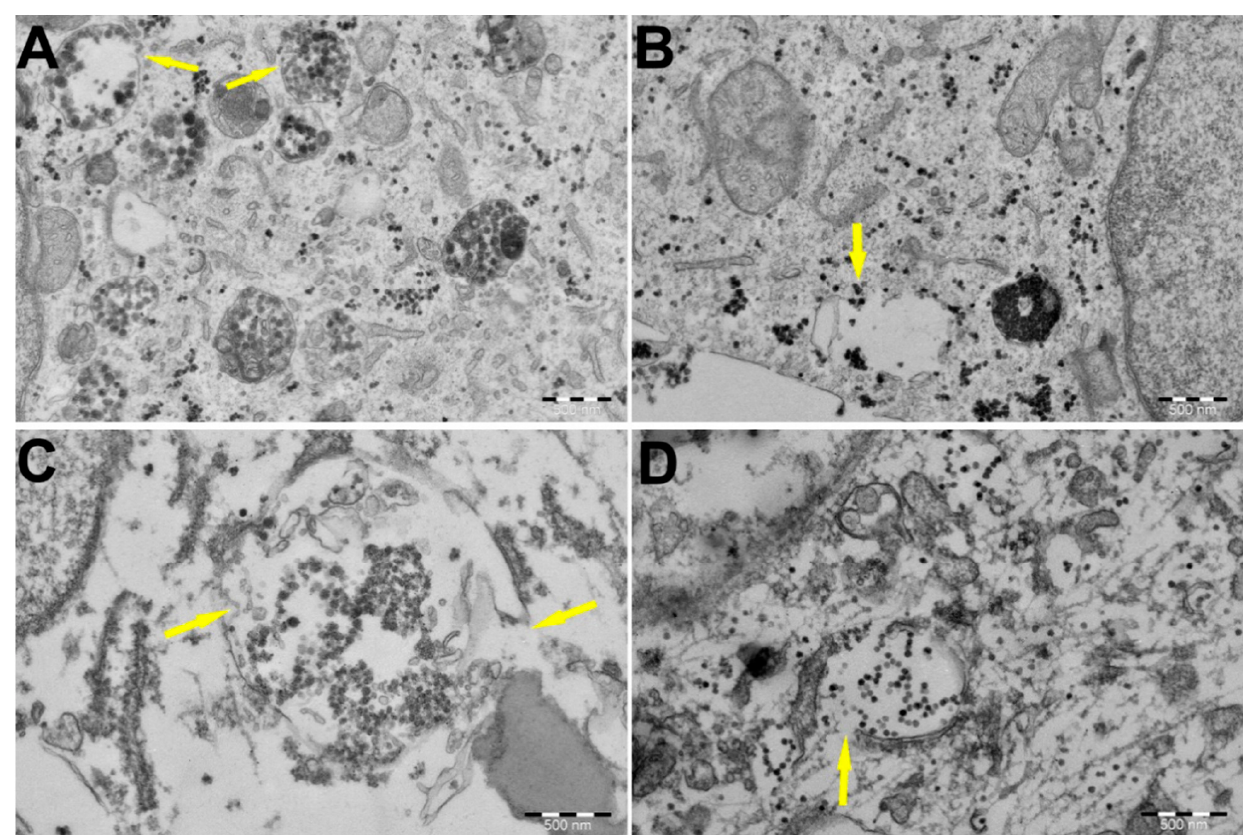
Figure 7. TEM imaging of the BT-12 (cultured in stem cell conditions) GSCs revealed the subcellular localization of the PEI-MSNs. PEI-MSNs were localized throughout the cells after 24 h. ( A ) Yellow arrows mark the potential endosomal escape of the PEI-MSNs via lysosomal membrane rupture. ( B ) PEI-MSNs in close proximity of a lysosome. ( C , D ) A close-up view of the affected lysosomes, suggesting a rupture of membranes and widespread localization of the PEI-MSNs.